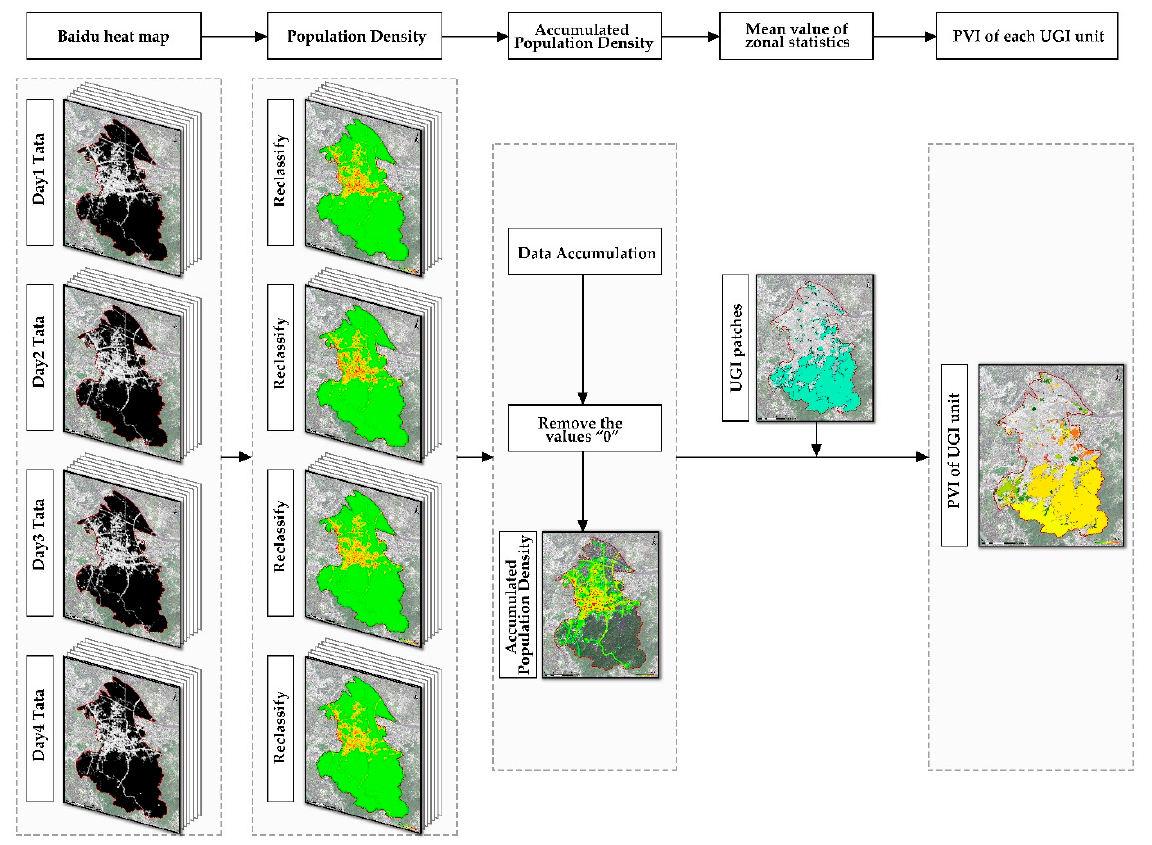
Figure 6. Flowchart of PVI analysis.